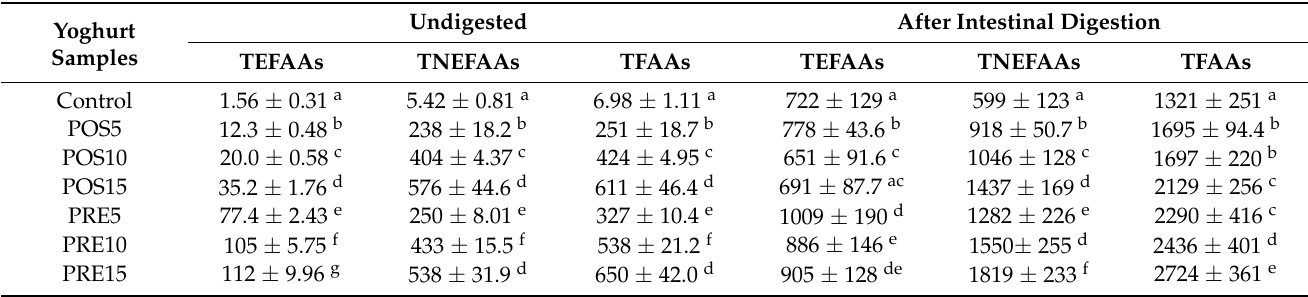
Table 1. Concentrations (mg/100 g yoghurt) of total free amino acids in control and tamarillo fortified yoghurts in undigested and after intestinal in vitro